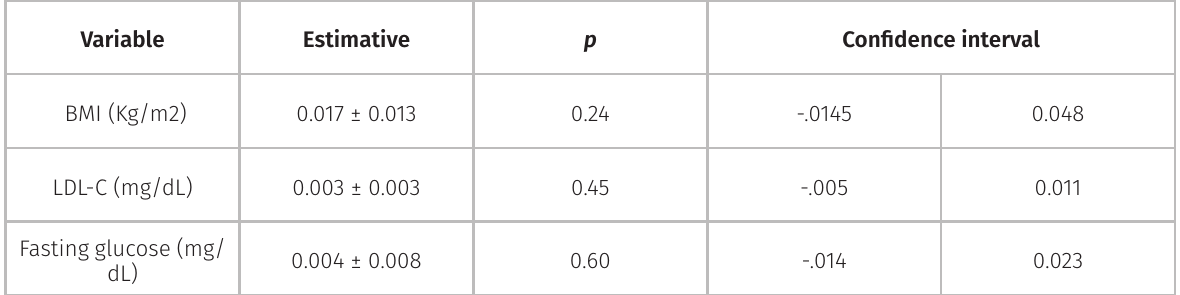
Table V. Multiple regression analysis between hsa-mir-150-5p expression and BMI, LDL-C and fasting glucose.